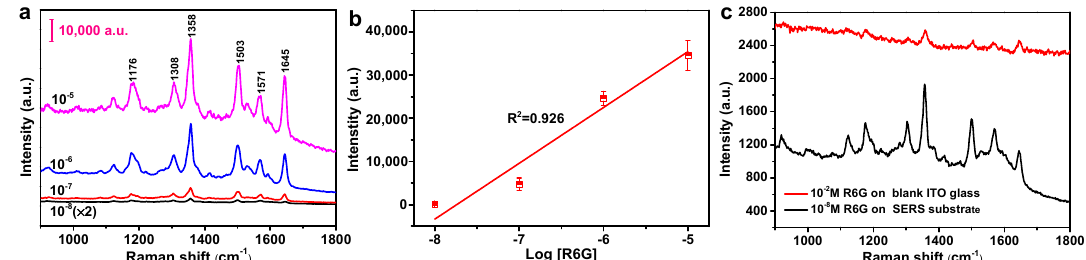
Figure 6. ( a ) SERS spectra of R6G with different concentrations on the silver nanoaggregates with the irradiation intensity and time of 4.5 × 10 5 W/cm 2 and 15 min, respectively. ( b ) Raman intensity of R6G at 1358 cm − 1 as a function of different concentrations in log scale. ( c ) SERS signals of 10 − 8 M R6G on the silver nanoaggregates and 10 − 2 M R6G on the ITO glass substrate, respectively. The power of the excitation laser was 38.2 μ W, and the acquisition time was 10 s for each spectrum.